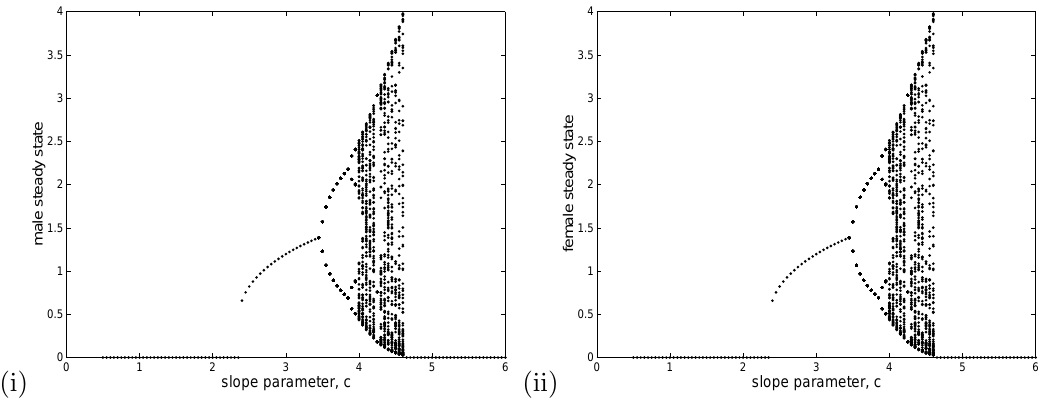
Figure 2: The dynamical solution at equilibrium of the two-sex model (3) using equations (5) and (6). (i) Male stock against the parameter c . (ii) Female stock against the parameter c , where θ = 0 . 5 , σ = 0 . 0 and the delay factors are u = v = 0